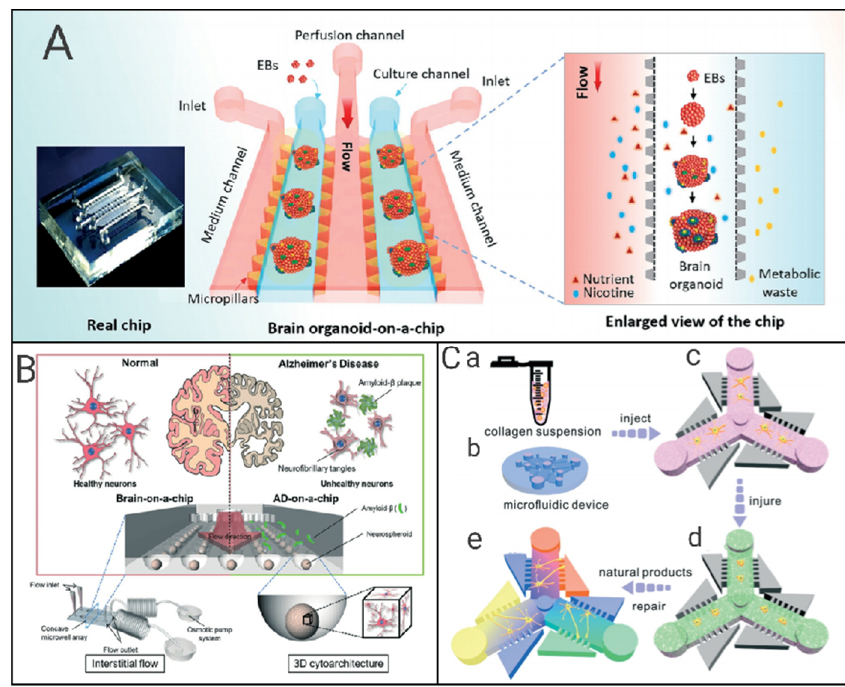
Figure 4. Schematic diagram of the research progress of neural chips. ( A ) The structure of the human brain organoid-on-a-chip to model prenatal nicotine exposure [112]. ( B ) Three-dimensional brain-on-a-chip with an interstitial level of flow and its application as an in vitro model of Alzheimer’s disease [114]. ( C ) A 3D microfluidic device to quantify orientational regeneration of injured neurons in AD by natural product concentration gradients [115].